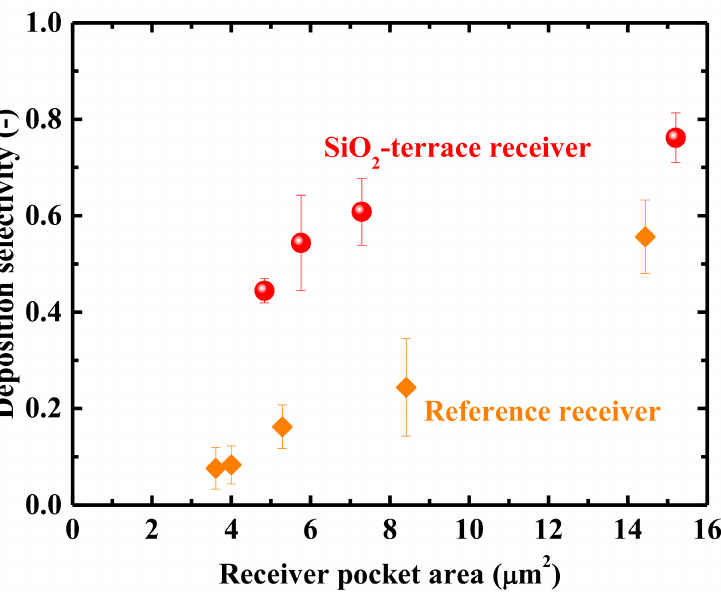
Figure 6. Deposition selectivity, defined as the fraction of the number of the Si microchips observed in the pockets out of that on the whole surface of the receiver (pockets + terrace), on the area of the receiver’s